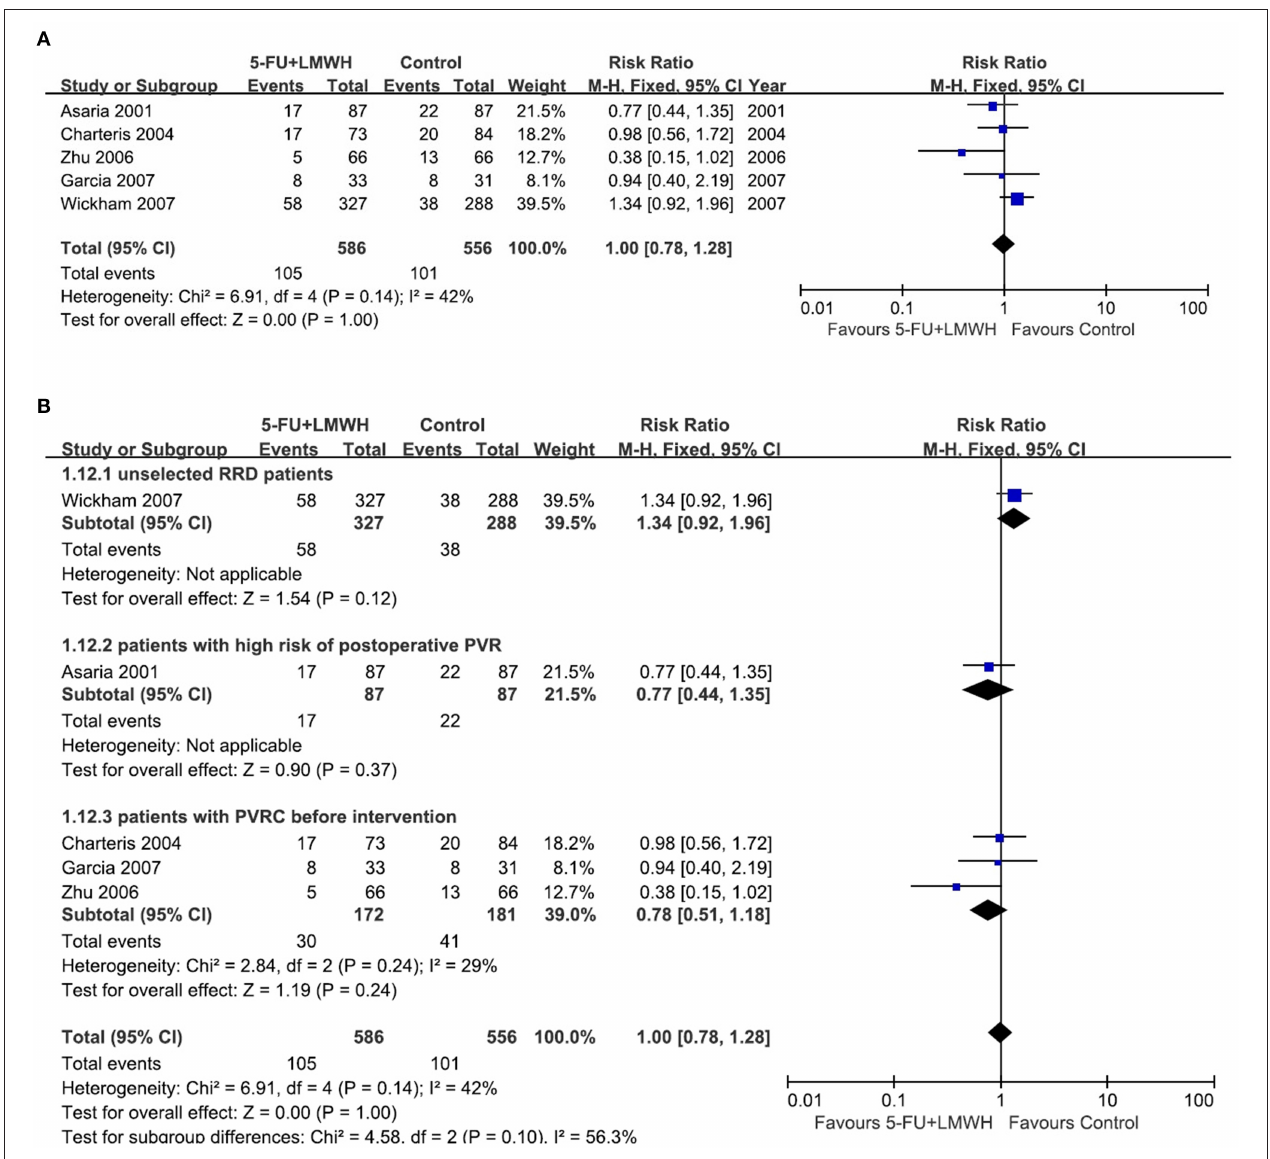
FIGURE 6 | Forest plots for the meta-analysis of the number of patients who underwent vitreoretinal reoperations. (A) Overall meta-analysis; (B) Subgroup analysis according to preoperative PVRC ratio.